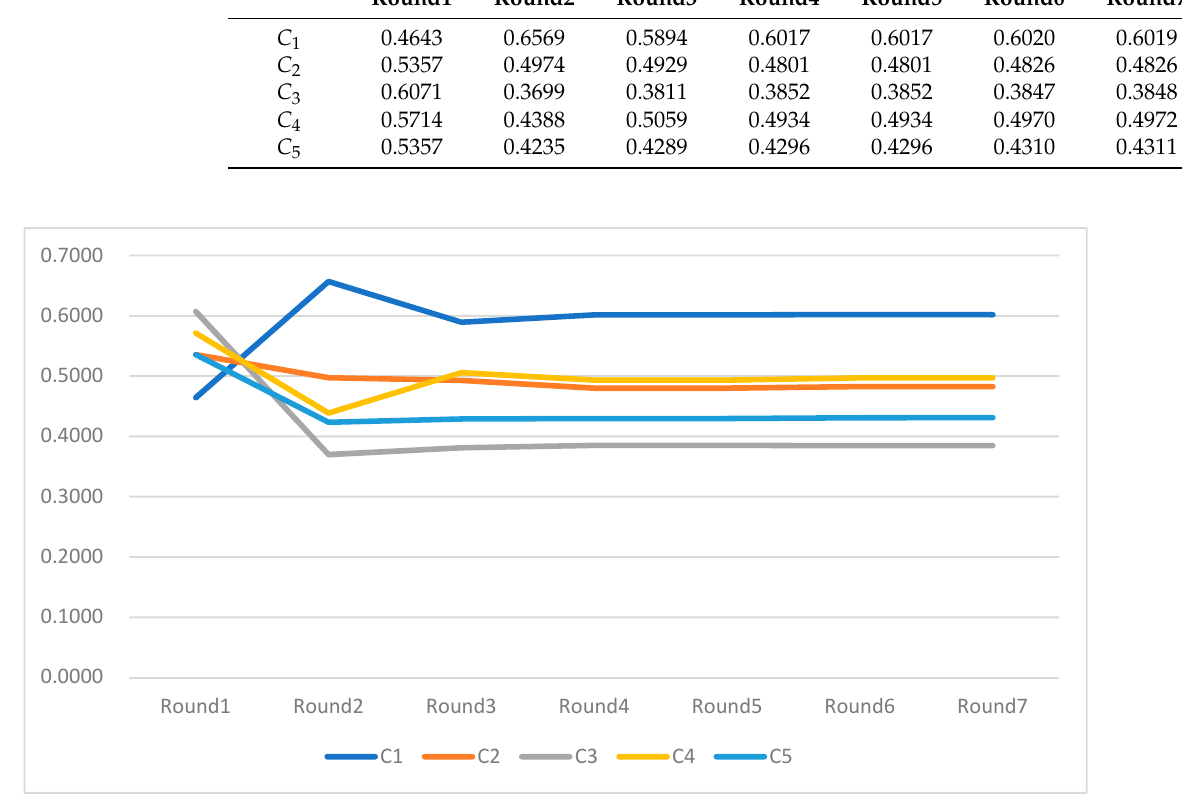
Figure 3. Interactive trend of each criterion.